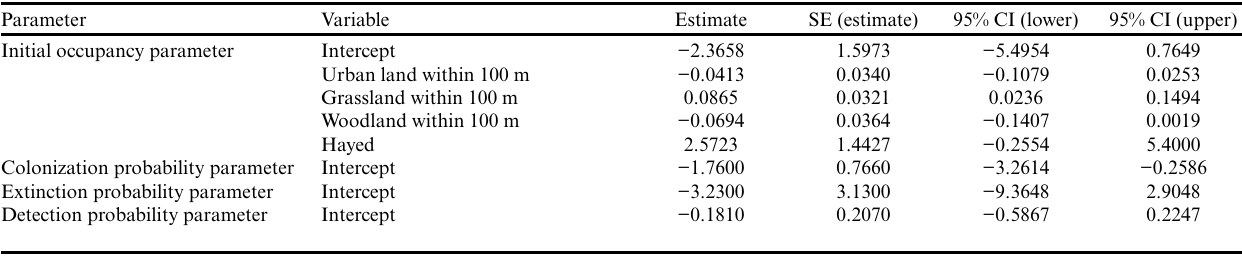
Table 5. Highest ranking multiseason occupancy model for Western Meadowlark along 47 transmission line study sites in Winnipeg, Manitoba, Canada in 2008–2009. AICc = 255.90, Δ AICc = 0.00, AIC weight = 0.34, N = 276 surveys. Total Mackenzie-Bailey